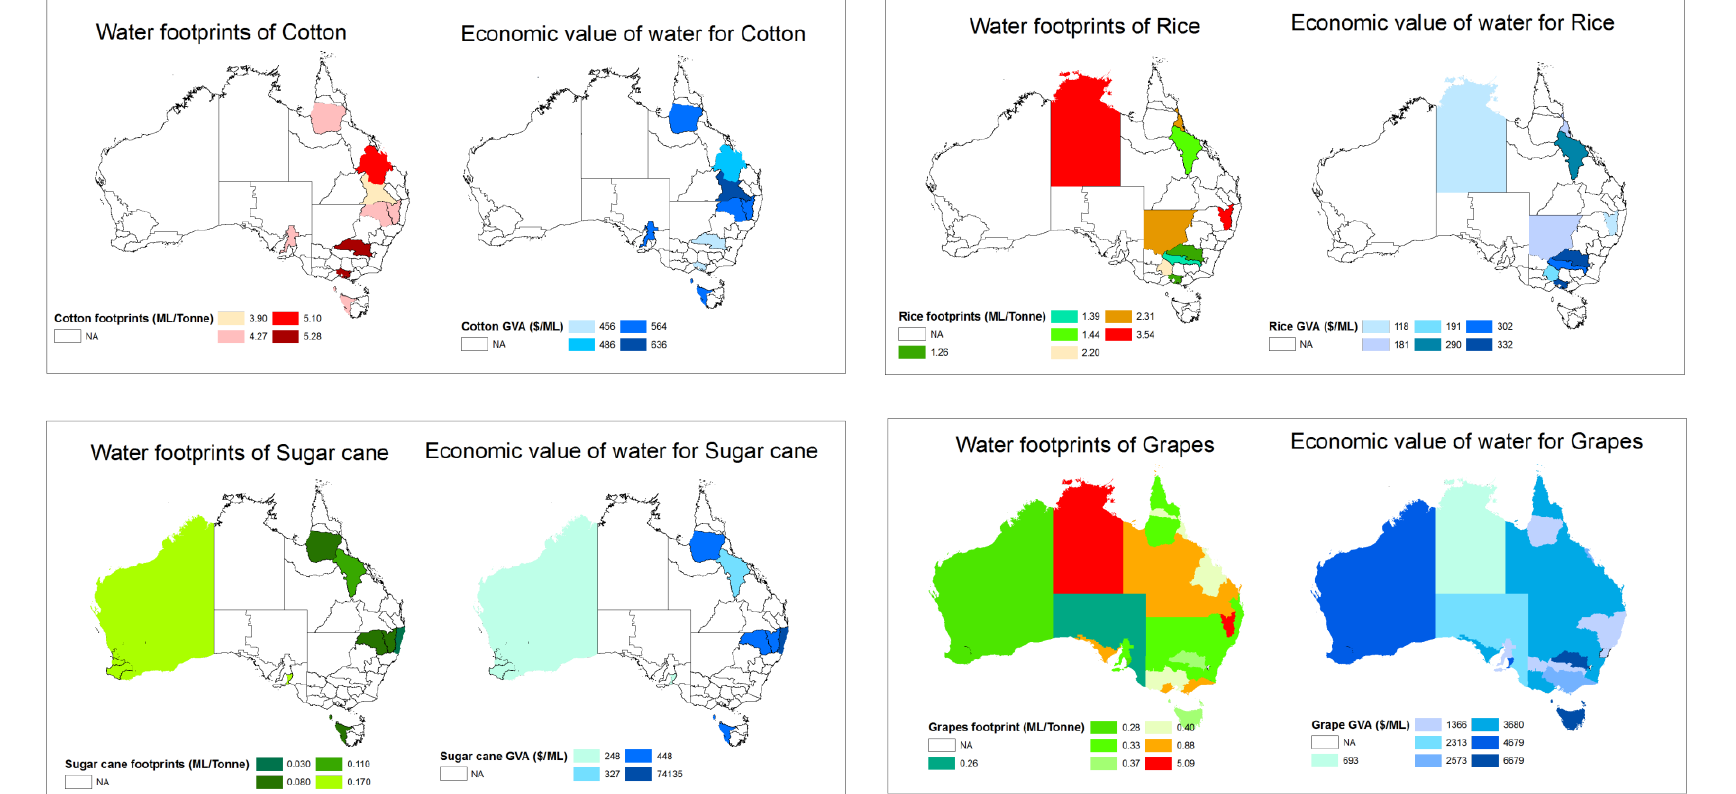
Figure 6. Detailed analysis of water footprints (red shades are above the global average and green are below the global average) and economic value of water for major crops in Australia.